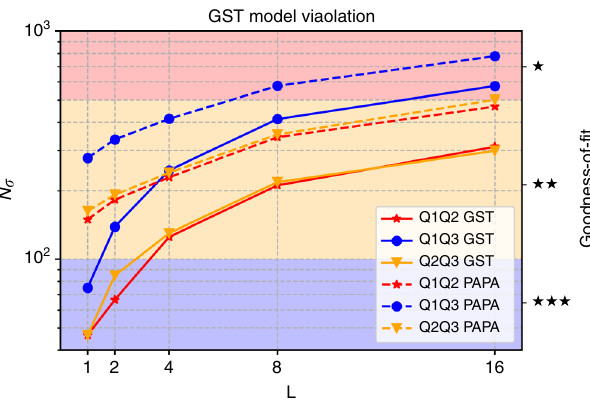
Fig. 2 GST (solid lines) and PAPA reconstruction (dashed-lines) N σ vs. germ power L for each of the three experimental data sets. N σ quanti fi es the deviation from a Markovian qubit model. The goodness-of- fi t parameter is provided by pyGSTi and ranges from single blackstar to fi ve black stars, indicating how well the data fi ts the implicit model. Larger values of L correspond to increased sensitivity to gate error and to longer